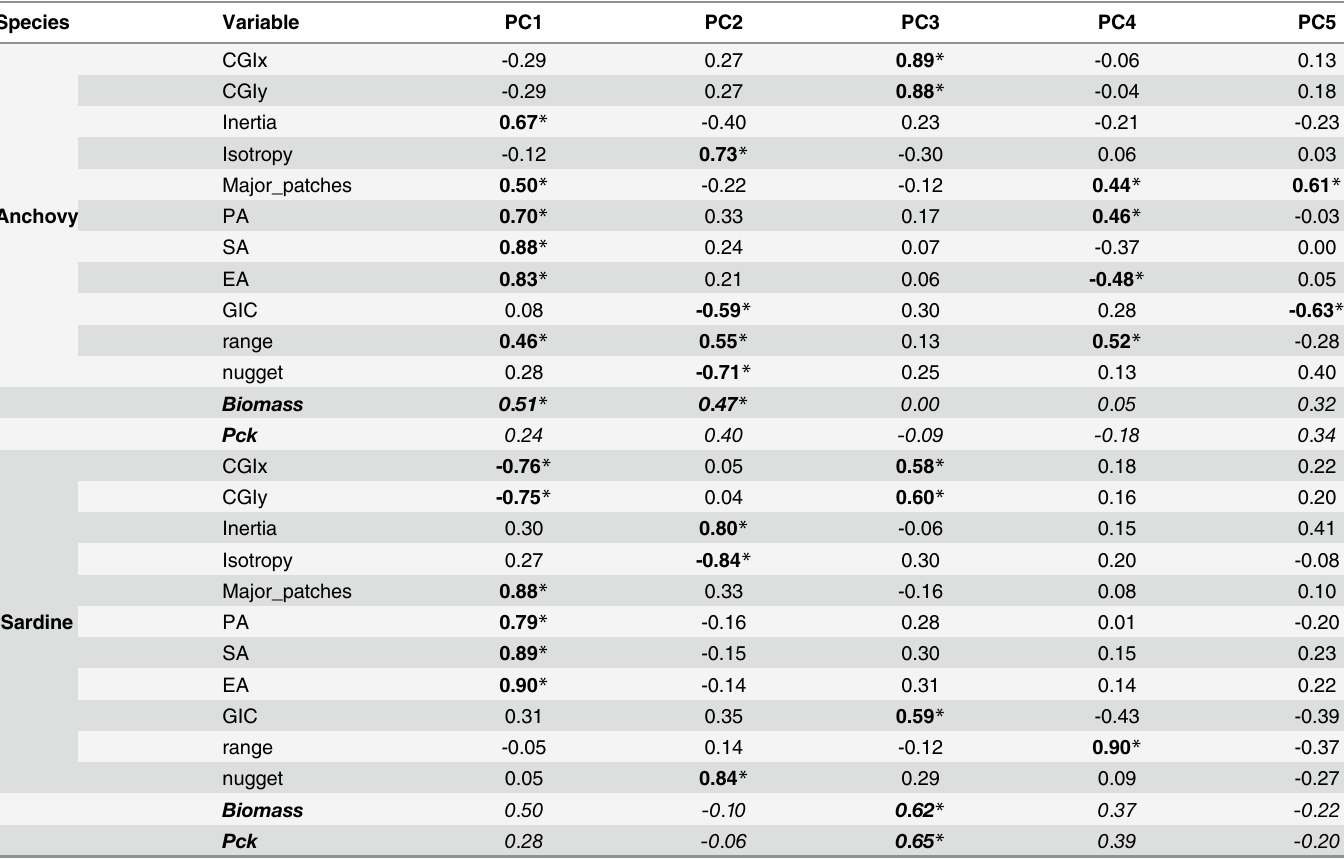
Table 2. Principal Component loadings per species. Supplementary variables are shown in italics. Significantly correlated variables on each axis are marked with an ( * ) and shown in bold. Species